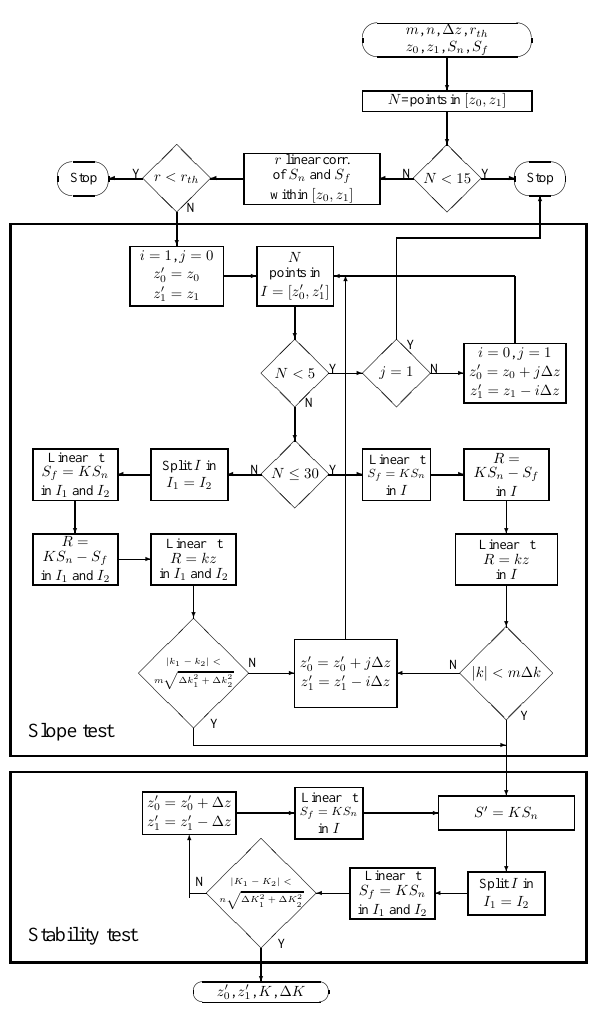
Figure 3. Work flow diagram of the automatic algorithm for the glu- ing of near-range and far-range lidar signals implemented in